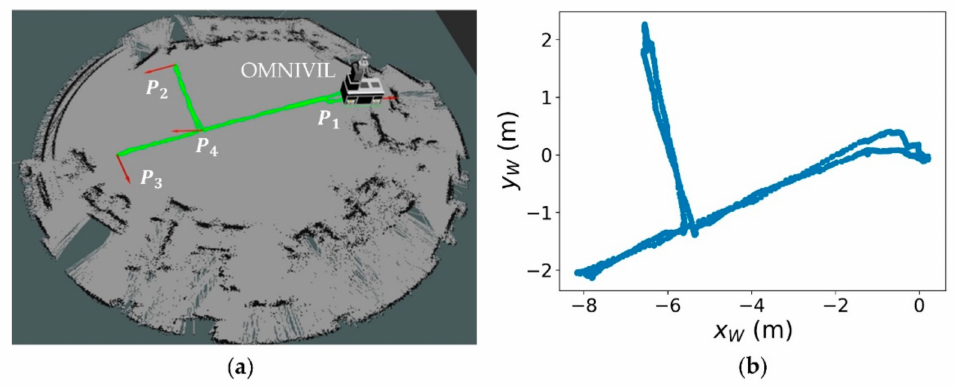
Figure 17. Sequential movement through the model factory. ( a ) Executed path and positions P 1 , P 2 , P 3 and P 4 , with OMNIVIL parking at reference pose P 1 ; ( b ) executed path in the static world coordinate system W .